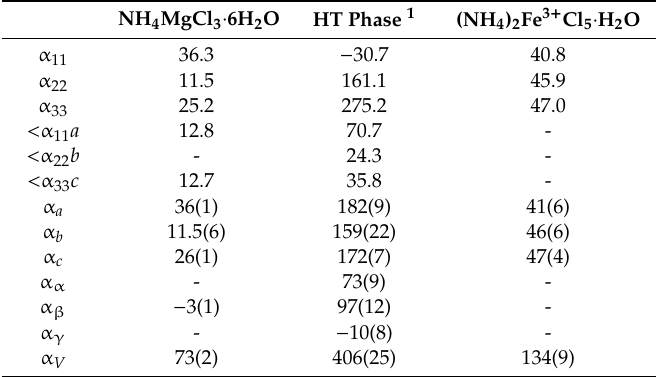
Figure 5. The dependencies of the unit-cell parameters versus temperature for (NH 4 ) 2 Fe 3+ Cl 5 ·H 2 O phase. Table 11. The main characteristics of thermal expansion of NH 4 MgCl 3 · 6H 2 O, its HT phase and